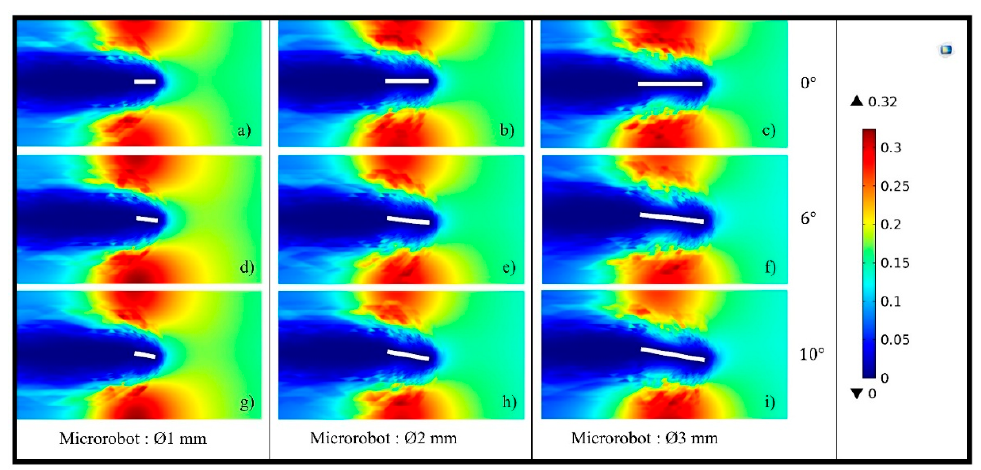
Figure 7. Microrobot study limits are determined. Accordingly, the minimum and maximum points are shown in the range of 31.0 µm (red)–329.1 µm (blue).